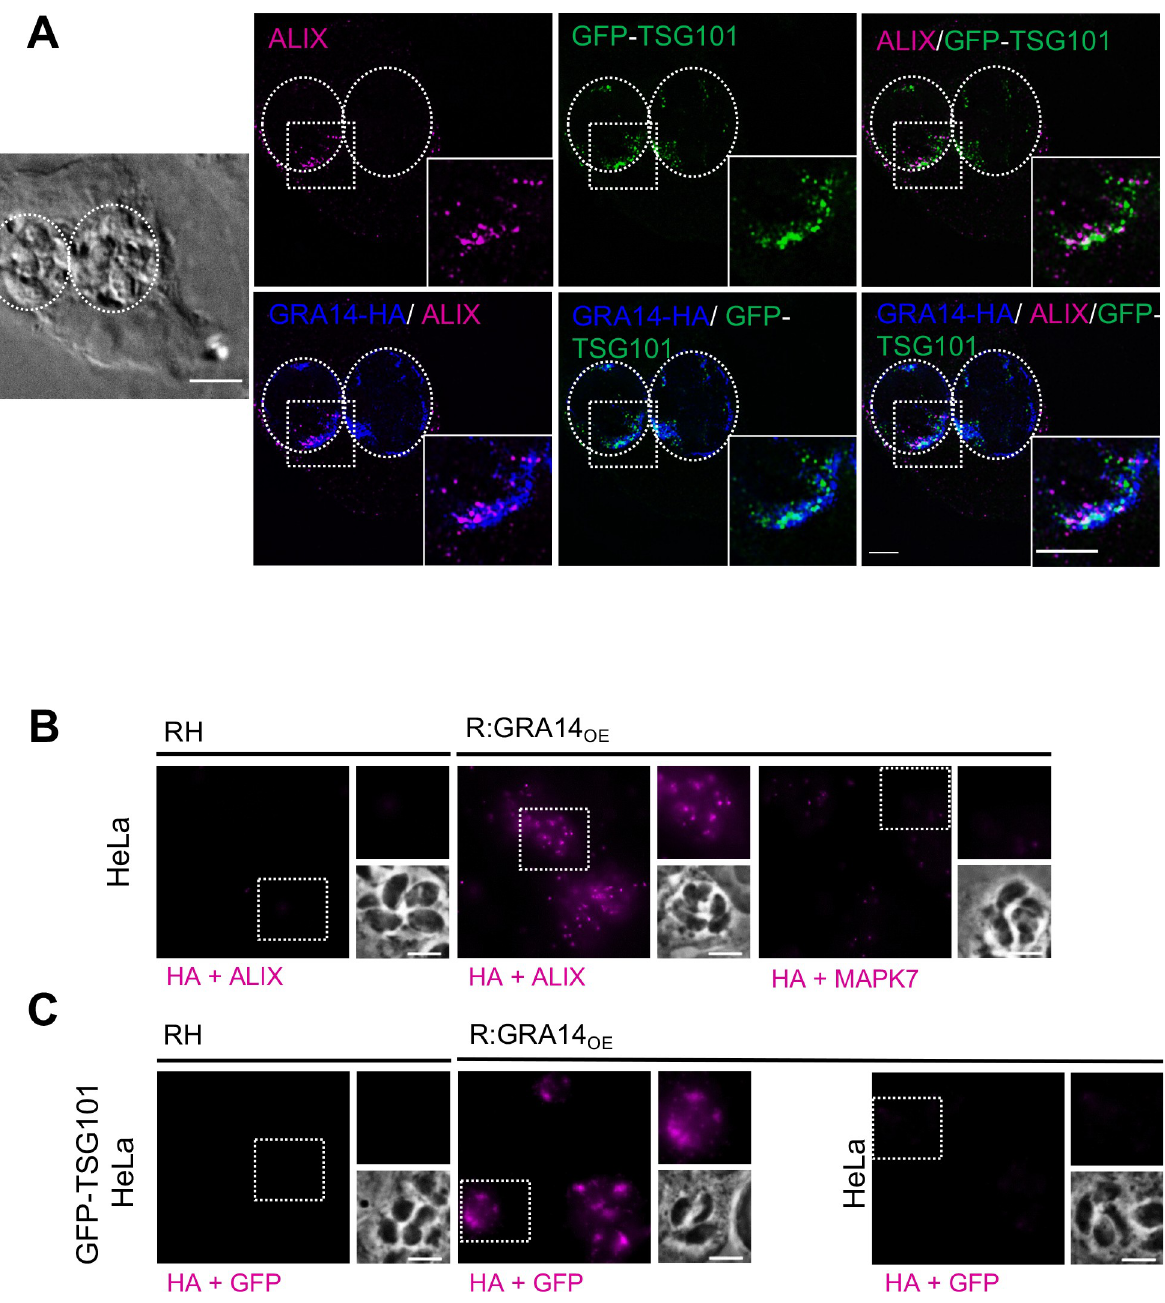
Fig 3. TgGRA14 is proximal to GFP-TSG101 and ALIX. A. Recruitment of host ALIX and TSG101 with TgGRA14. GFP-TSG101 HeLa cells infected with TgGRA14-HA over expressing parasites (R:GRA14 OE ) were stained for the anti-ALIX and anti-HA. Representative images analyzed by structured illumination microscopy. 3D Projections. Scale bar is 5 μ m. B. Proximity Ligation assay (PLA) reaction from samples infected with either WT or R:GRA14 OE strains. PLA reactions were performed using antibodies for the host ALIX and the HA-tag to analyze the interaction of TgGRA14 with ALIX. PLA reaction using antibodies against host MAPK7 and HA-tag, was used a negative control. Representative images from at least 3 biological replicates. Scale bar is 5 μ m. C. PLA reaction from GFP-TSG101 HeLa infected with either WT or TgGRA14-HA strains. PLA reactions were performed using antibodies for GFP and the HA-tag to analyze the interaction of TgGRA14 with TSG101. PLA reaction using antibodies against GFP and the HA-tag in WT HeLa cells was used a negative control. Representative images from at least 3 biological replicates. Scale bar is 5 μ m.